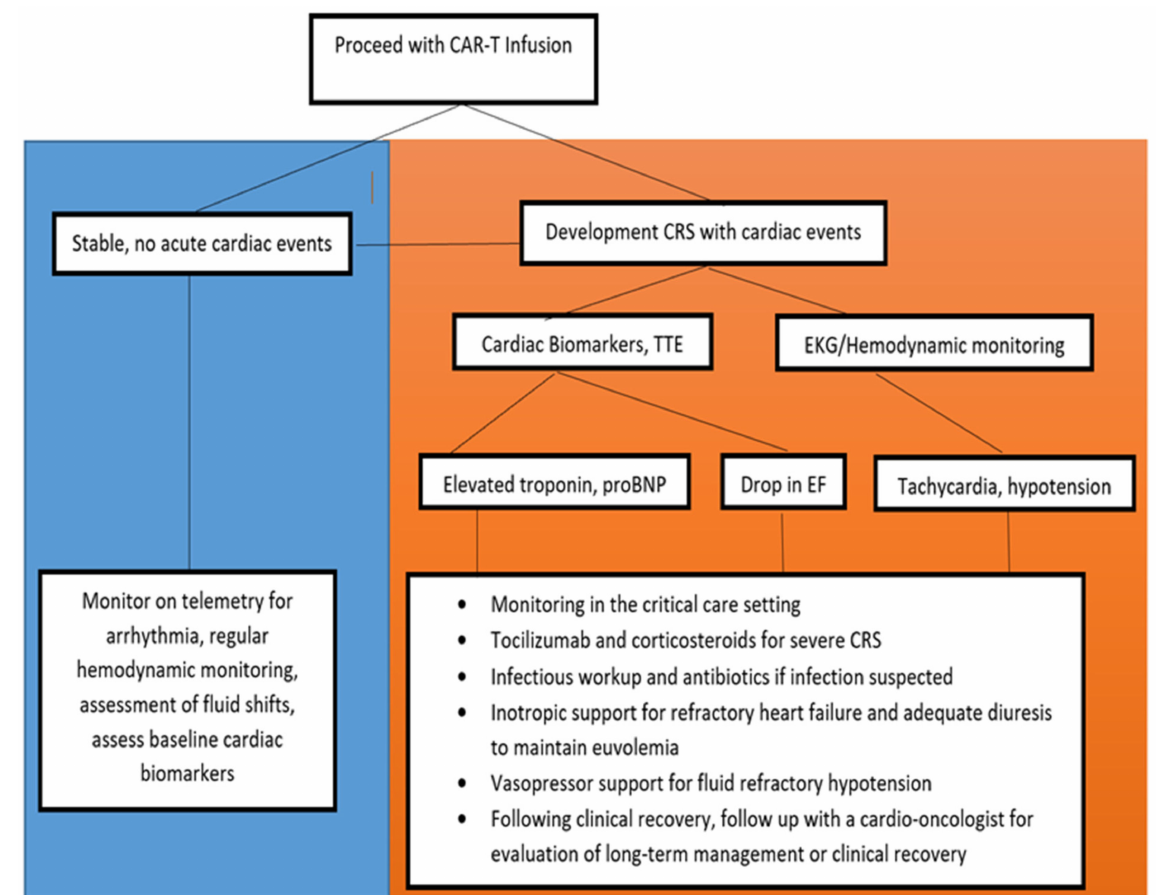
Figure 3. Management consideration in patients that develop CRS that may be at risk for cardiotoxicity. CRS: Cytokine release syndrome. TTE: Transthoracic echocardiogram; EKG: Electrocardiogram; EF: Ejection fraction; proBNP: Brain natriuretic